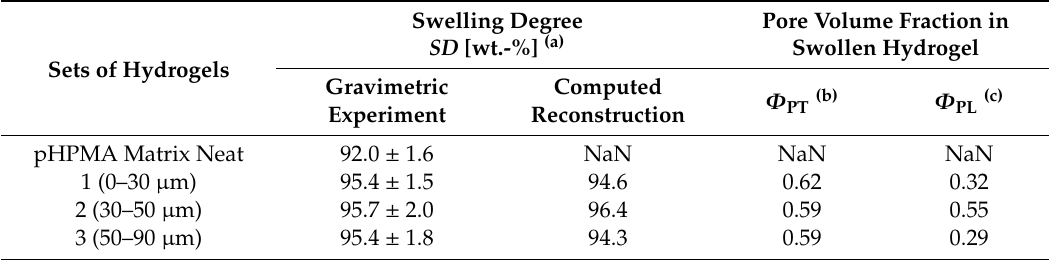
Table 4. Swelling of macroporous hydrogels determined gravimetrically; swelling estimated from computer reconstruction; volume fractions of porogen-formed pores calculated from swelling, φ PT , and large pore volume fraction; φ PL , estimated from reconstructed LSCM z-stacks (c.f. Section 3.5). (a) Swelling degree SD is expressed as the percentage of water in the equilibrium swollen gel according to Equation (1). SD value from the computer reconstruction was obtained by counting the matrix voxels and void voxels in the total depicted volume and from the experimentally determined swelling of the hydrogel matrix. The reference volume of pores estimated from the reaction mixture composition was 0.60 (volume of NaCl added). (b) φ PT is the volume fraction of pores imprinted by salt particles calculated from equilibrium swelling. (c) φ PL is the volume fraction of large pores according to computer volume reconstruction. Swelling Degree Pore Volume Fraction in SD [wt.-%] (a) Swollen Hydrogel Sets of Hydrogels Gravimetric Computed Φ (b) Φ (c) PT PL Experiment Reconstruction pHPMA Matrix Neat 92.0 ±